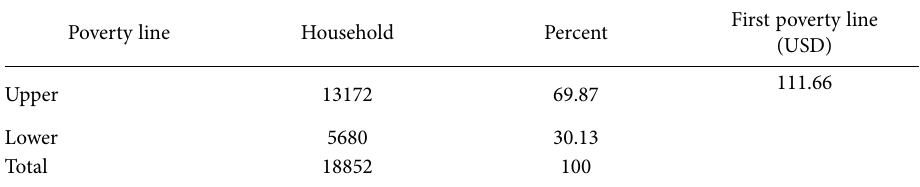
Table 5. The effect of rising food prices on poverty in urban households (Poverty line for urban house-